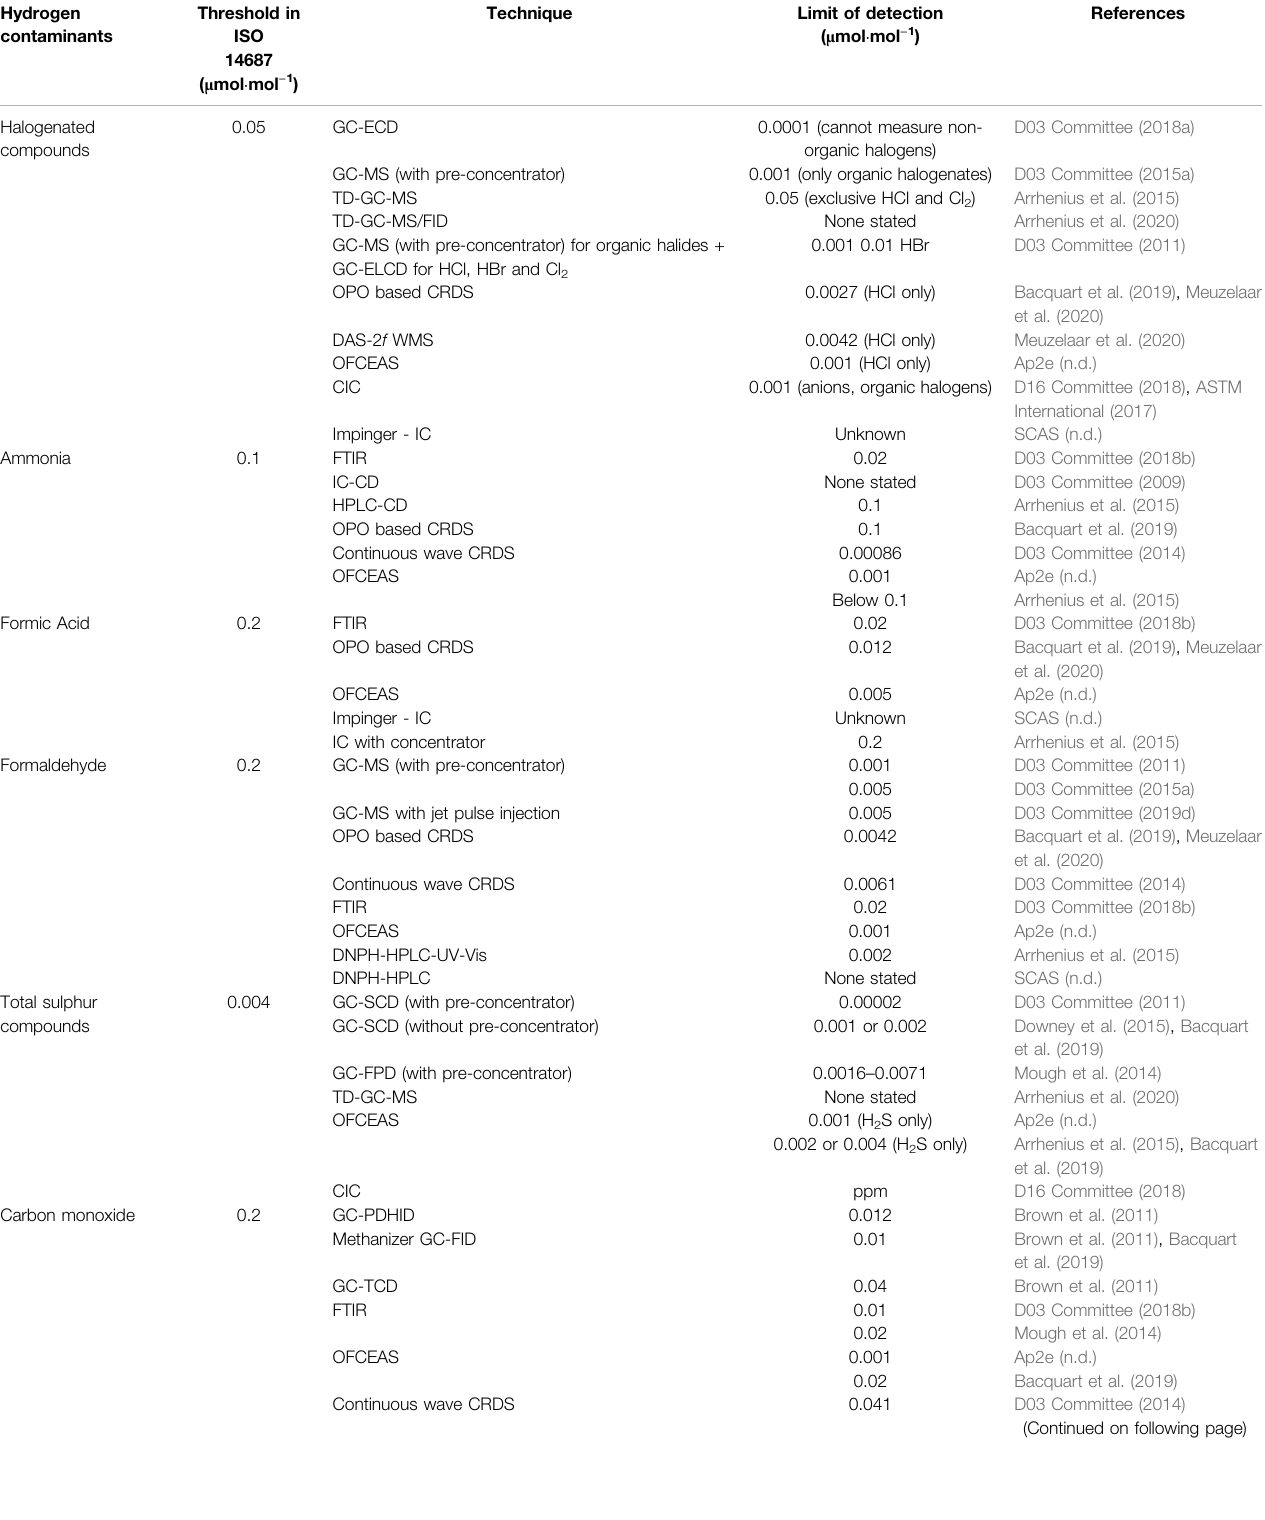
TABLE 10 | Analytical methods from the bibliographical study per impurity with detection limit above the control